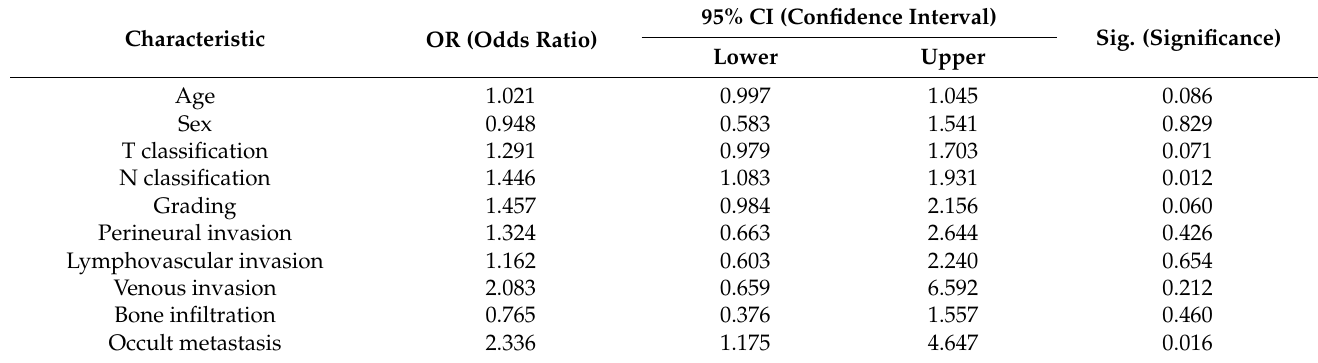
Table 3. Cox regression model, predictors for progression-free